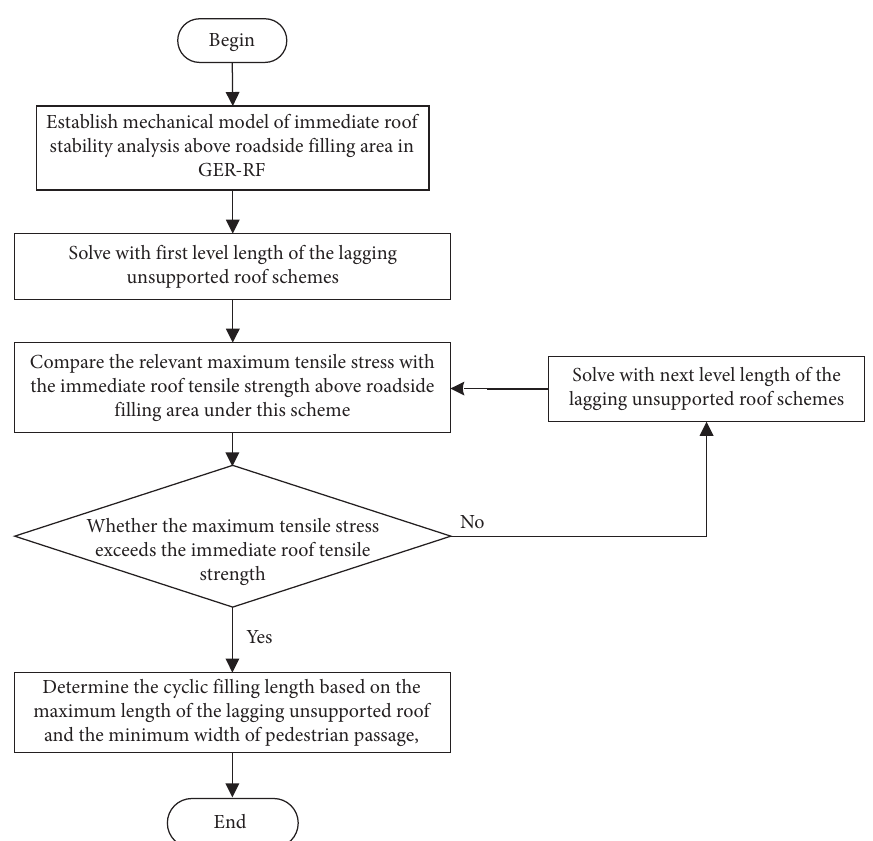
Figure 5: Calculation flow of the cyclic backfill length of GER-BB based on the stress difference